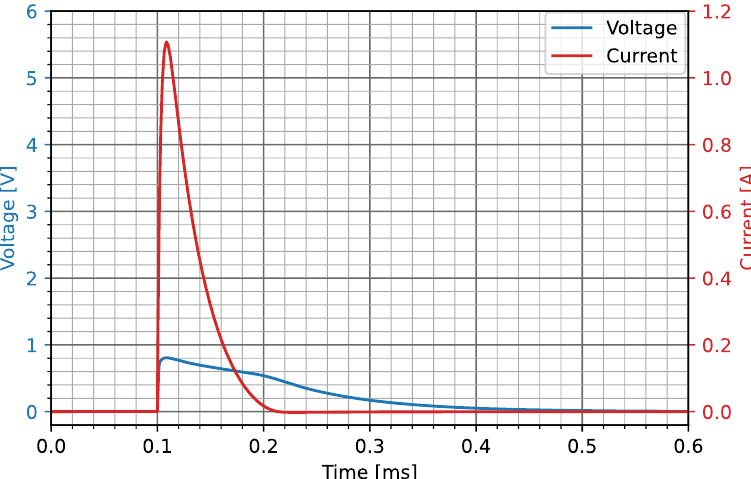
Figure 38. Simulated voltage and current curves (large-signal transient stimulus, applied in the forward